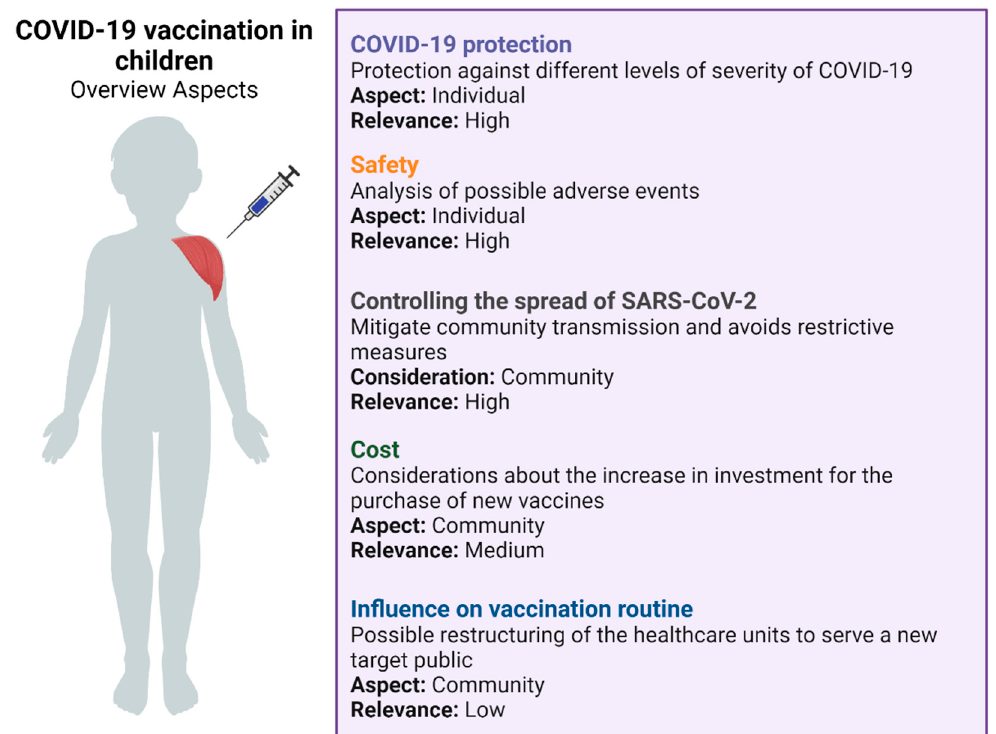
Figure 2. Overview about infantile vaccination for COVID-19. Adapted from Zimmerman et al. [203]. Created with BioRender.com (accessed on 5 March 2022).